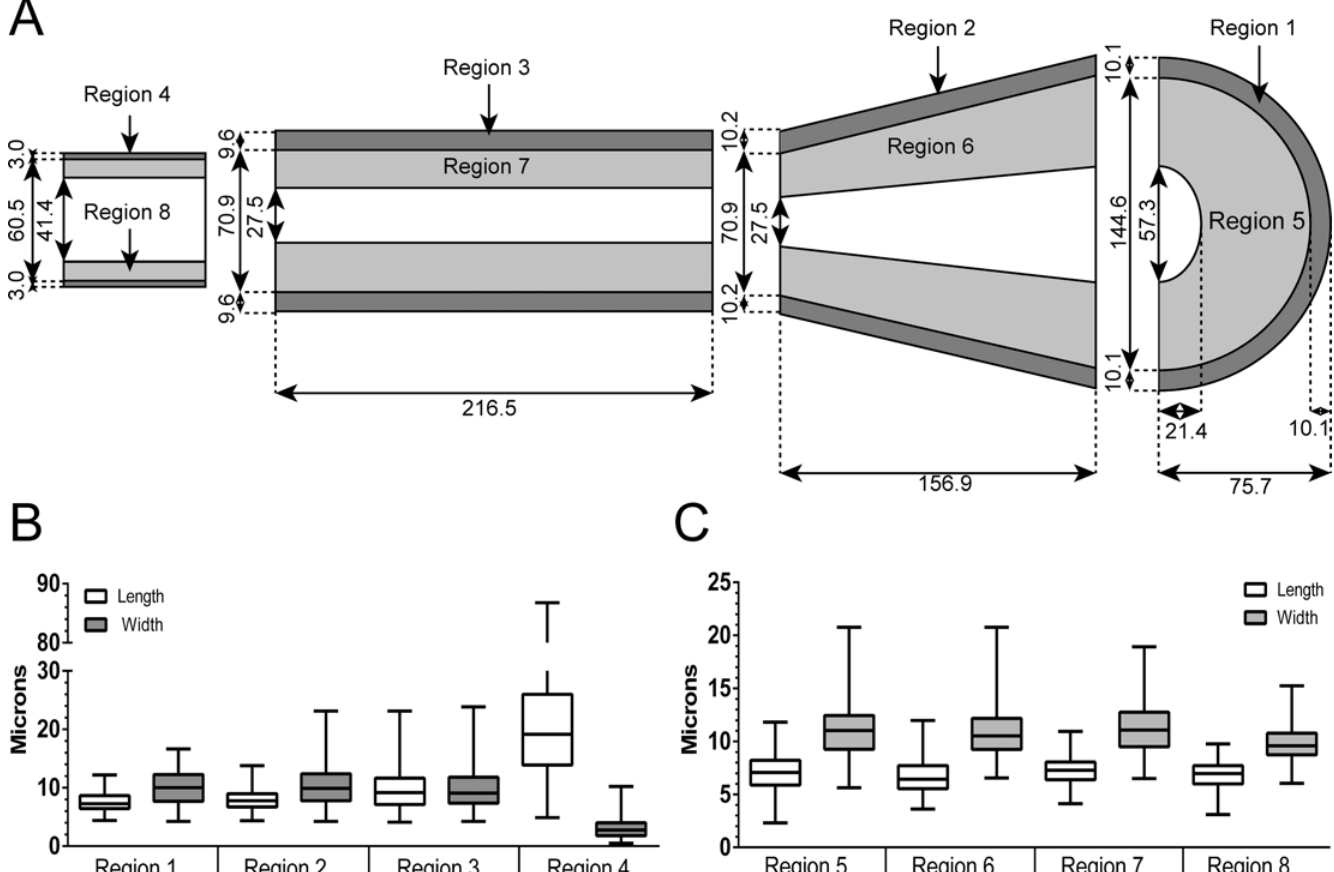
Fig 1. Morphology characterization of the terminal end bud. Glands from 5 and 6 week old mice were embedded, sectioned and stained for epithelial markers and measurements were taken of both cells and the TEB structure. A) Regional measurements of the TEB are represented in a scaled schematic (n values: Regions 1, 2, 5, and 6 = 15 TEBs, Region 3 = 23 TEBs, Region 4 = 8 TEBs, Region 7 layer diameter = 24 TEBs, lumen = 15 TEBs, length = 29 TEBs, Region 8 = 8 ducts). B) Mean cellular dimensions of the cap and myoepithelial cells, Regions 1 – 4 (whiskers denote range, n values: Region 1 length = 15 TEBs/ 45 cells, Region 1 width = 10 TEBs/ 126 cells. Region 2 length = 15 TEBs/ 56 cells, Region 2 width = 10 TEBs/ 115 cells. Region 3 length = 23 TEBs/ 273 cells, Region 3 width = 9 TEBs/ 36 cells. Region 4 length = 8 TEBs/ 197 cells, Region 4 width = 8 TEBs/ 197 cells). C) Mean cellular dimensions of body and luminal cells, Regions 5 – 8 (whiskers denote range, n values: Region 5 width/length = 5 TEBs/ 221 cells. Region 6 width/length = 5 TEBs/ 316 cells. Region 7 length/width = 4 TEBs/ 204 cells. Region 8 length/width = 6 ducts/ 301 cells). See also Table A in S1 Text and S2 Fig.